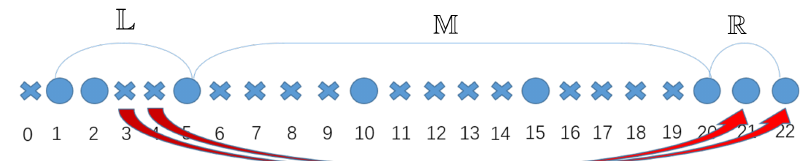
Figure 2. ANA configuration with R = 8, M = 3, N =